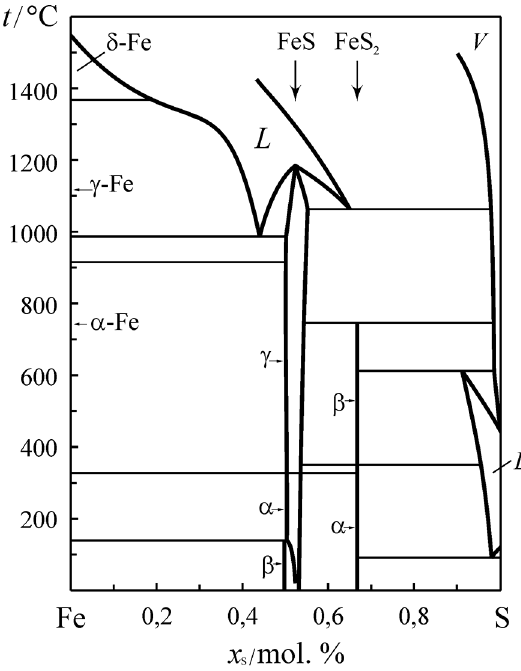
Figure 1. Phase diagram of the Fe–S system (according to ref. 7 ).